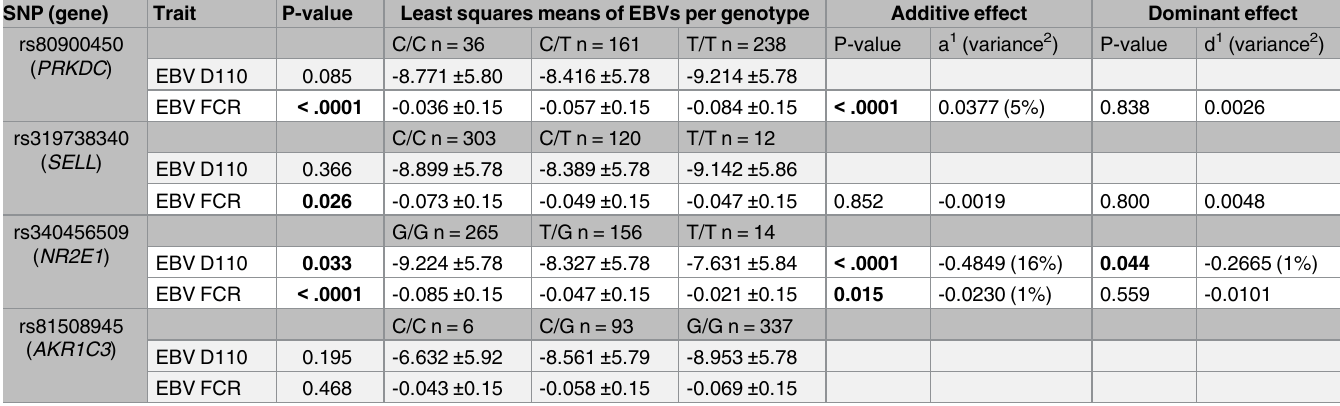
Table 6. Association of the five SNPs, located in selected functional genes mapped within 1Mb of the genome-wide significant markers, with breeding values for FCR and D110. Lower breedingvalues indicate higherfeed efficiency. SNP (gene) Trait